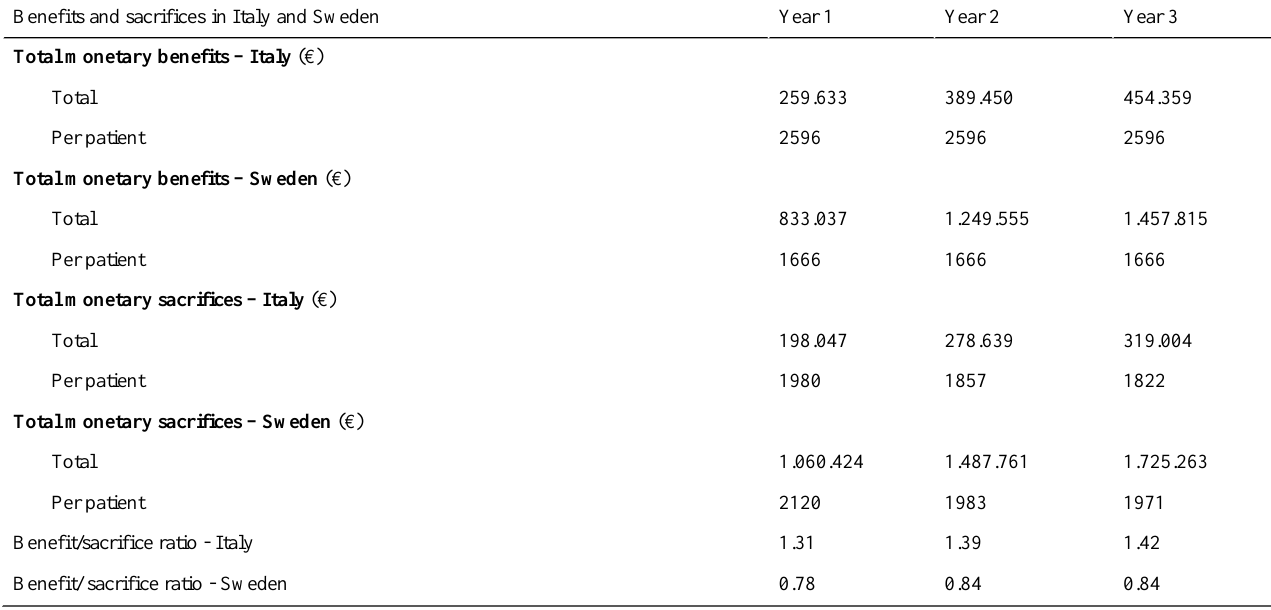
Table 4. Summary of the DECI scenario in monetary value, in euros (a currency exchange rate of EUR €1=US $1.18 is